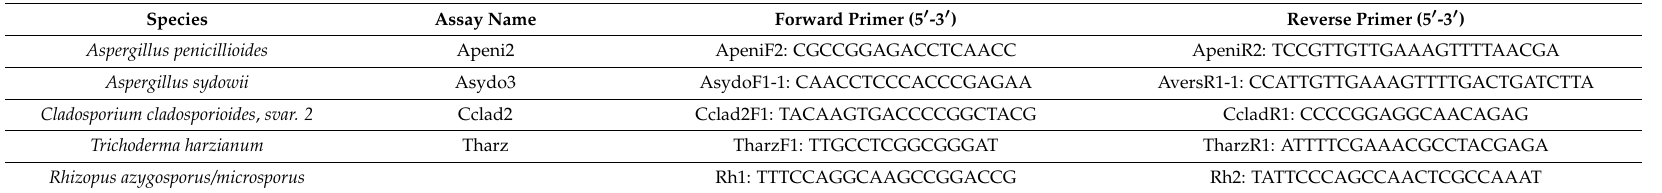
Table 1. Primers used for mold identification in this study